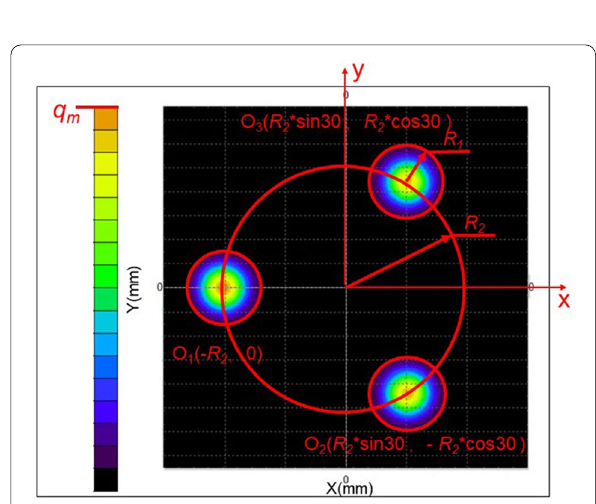
Figure 11 Power intensity contour image of three-beam laser at positive defocus cross-section